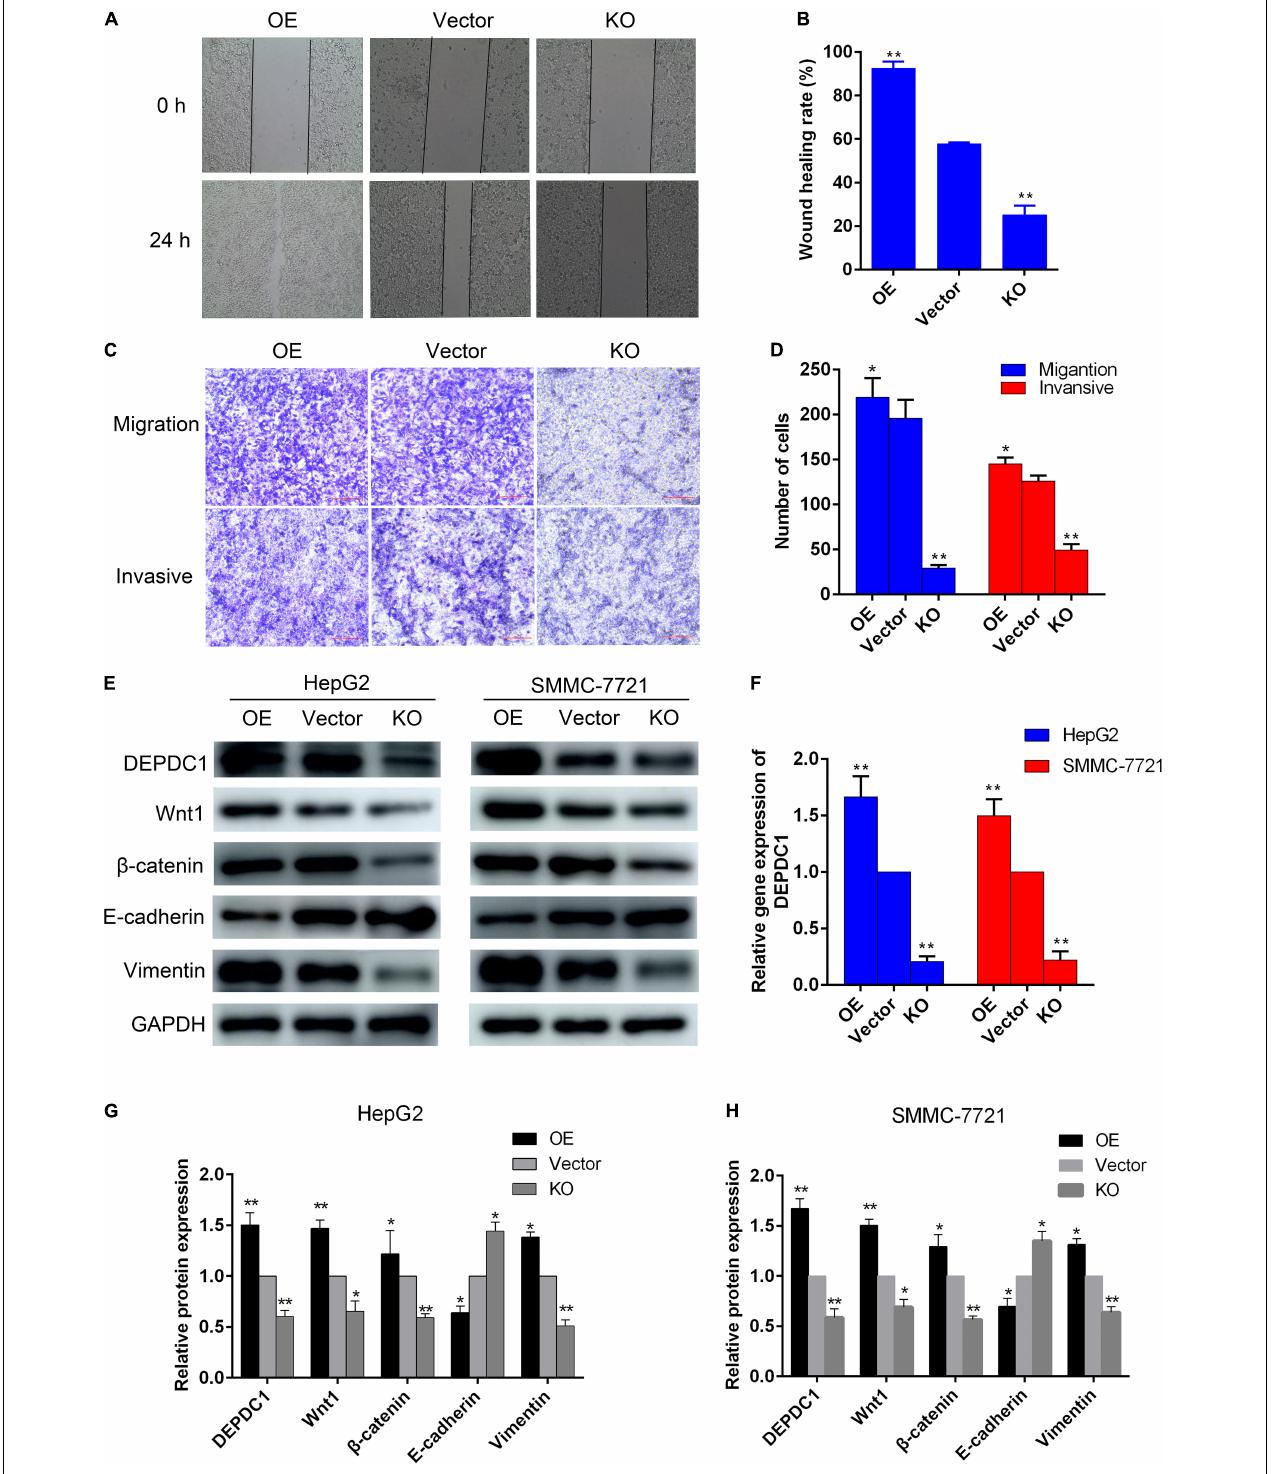
FIGURE 7 | DEPDC1 promotes HCC migration and invasion via Wnt/ β -catenin signaling pathway and EMT. (A) Representative images of wound healing assay. (B) Wound healing rate. (C) Representative images of transwell migration assay (without matrigel) and invasion assays (with matrigel). (D) Migration and invasion cell number. (E) Western blot analysis of DEPDC1, Wnt/ β -catenin, and EMT related proteins in DEPDC1 -OE and DEPDC1 -KO HCC cells. (F) Fold changes in DEPDC1 gene expression. (G,H) Fold changes in DEPDC1, Wnt/ β -catenin, and EMT related protein expression. Data are expressed as the mean ± SD of three independent experiments. * p < 0.05 and ** p < 0.01 vs. the vector group.